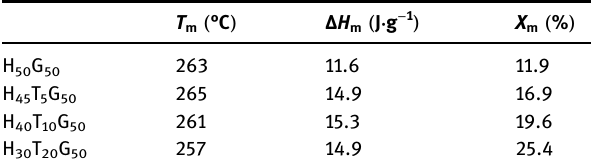
Table 2: DSC results derived from the fi rst warming scan for H 50 G 50